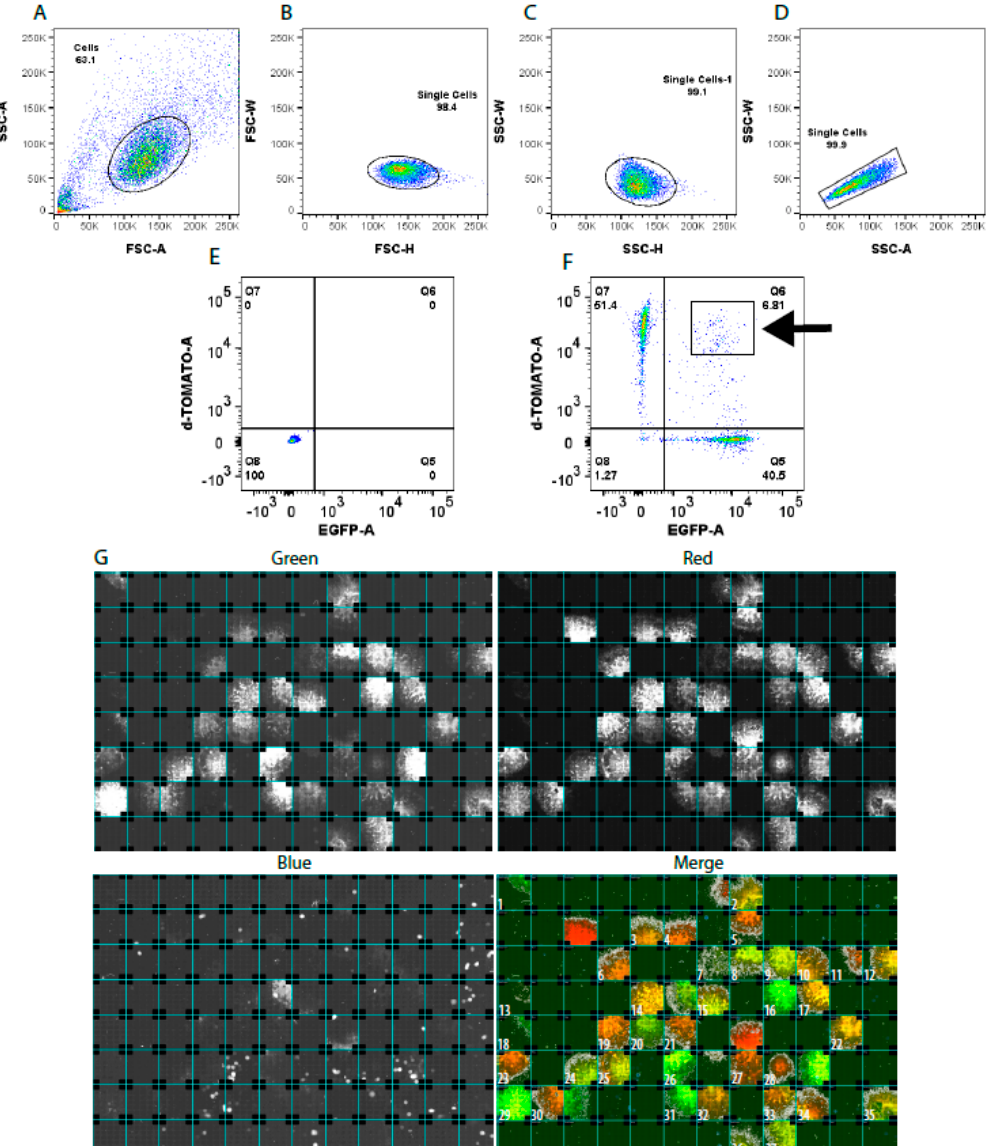
Figure 3. Sorting of single-cell isogenic induced pluripotent stem cells (iPSCs). ( A ) Selection of a live cell population and (B – D ) doublet-discrimination. ( E ) Generation of negative sorting gates using untransfected iPSCs. ( F ) Single-cell fluorescence activated cell sorting (FACS) sorting of dTOMATO + /EGFP + cells with restrictive gating (black arrow) into a 96 well plate. ( G ) High content screening of single-cell sorted plate showing the green, red, blue and merged channels.